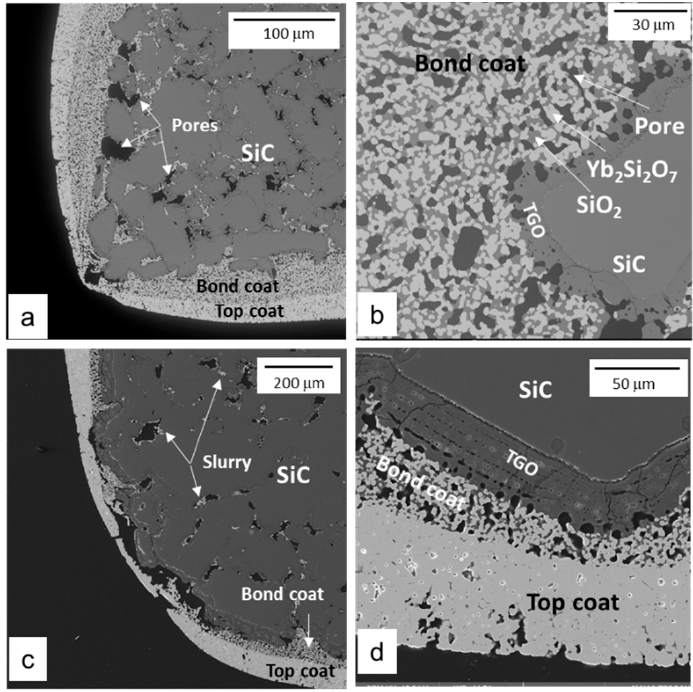
Figure 5. Cross-sections of EBC-coated SiC heating element after cyclic oxidation at 1427 °C in 90 vol.% H 2 O + 10 vol.% O 2 : ( a , b ) 100 h; ( c , d ) 500 h.